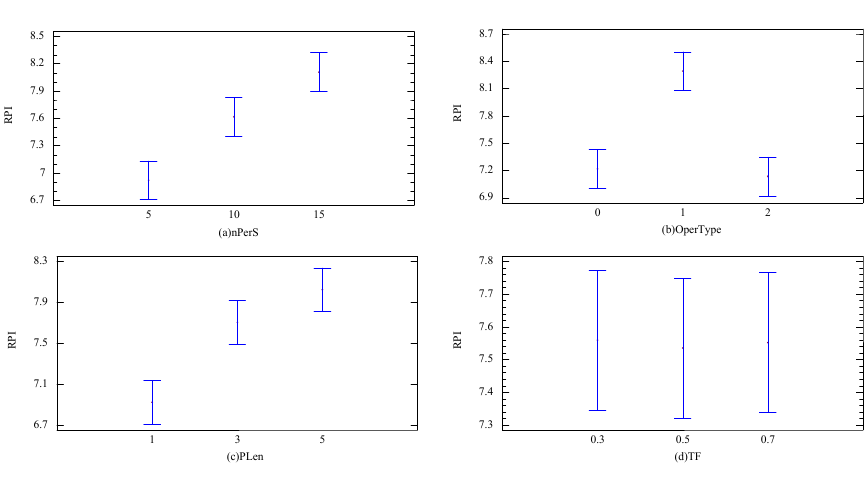
Fig. 6. Means plots for all factories for the ILS